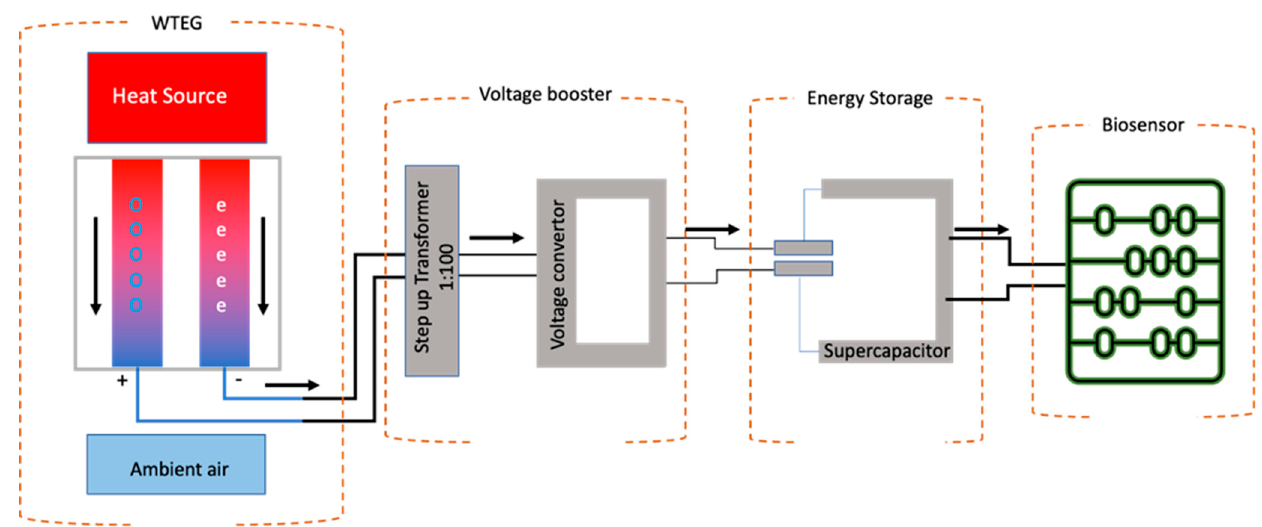
Figure 10. The schematic representation of a self-powered health monitoring system, referenced from